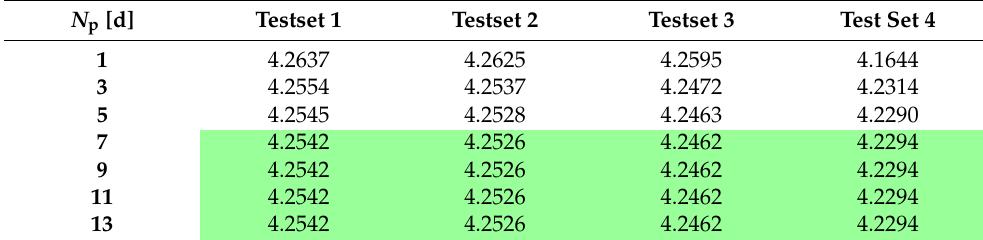
Table 4. Average value of water level ( h 1 ) throughout simulations [m].